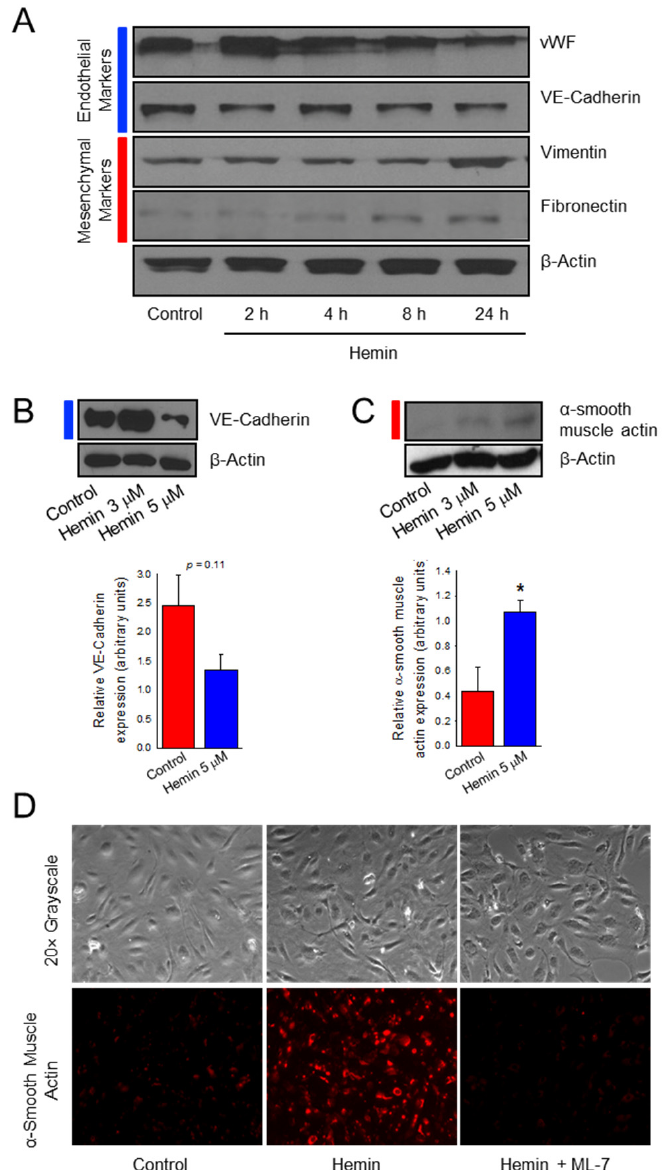
Figure 1. Hemin downregulates endothelial marker expression and upregulates mesenchymal marker expression in human pulmonary artery endothelial cells. ( A ) Western blot images denoting endothelial marker (blue bars) and mesenchymal marker (red bars) protein expression over time between hemin (5 µM)-treated and control (PBS vehicle)-treated HPAECs. Representative image model changes in a single experiment with reproducibility of target proteins confirmed at 8 and 24 h. Western blot images showing VE-cadherin ( B ) and α -smooth muscle actin ( C ) expression after treatment with 3 µM and 5 µM of hemin for 24 h as compared to PBS control with accompanying bar graph ( n = 5 and 4, respectively). ( D ) Immunofluorescence images depicting α -smooth muscle actin expression after 24 h with hemin (5 µM) treatment compared to control, and pre-treatment with the myosin light chain kinase (MLCK) specific inhibitor, ML-7 (20 µM). * indicates p < 0.05; vWF, Von Willebrand Factor; VE-cadherin, vascular endothelial cadherin; ML-7, myosin light chain kinase specific inhibitor. 2.2. Hemin Upregulates EndoMT Transcription Factors To validate that this upregulation of mesenchymal phenotype with downregulation of endothelial-specific cell markers is mediated by an EndoMT mechanism, he- min-treated cells were probed for expression of established EndoMT transcription fac- tors, zinc finger proteins SNAI1 and SLUG (SNAI2). In Figure 2, SNAI1 and SLUG ex- pression is upregulated in a time-dependent manner in hemin-treated cells when com-